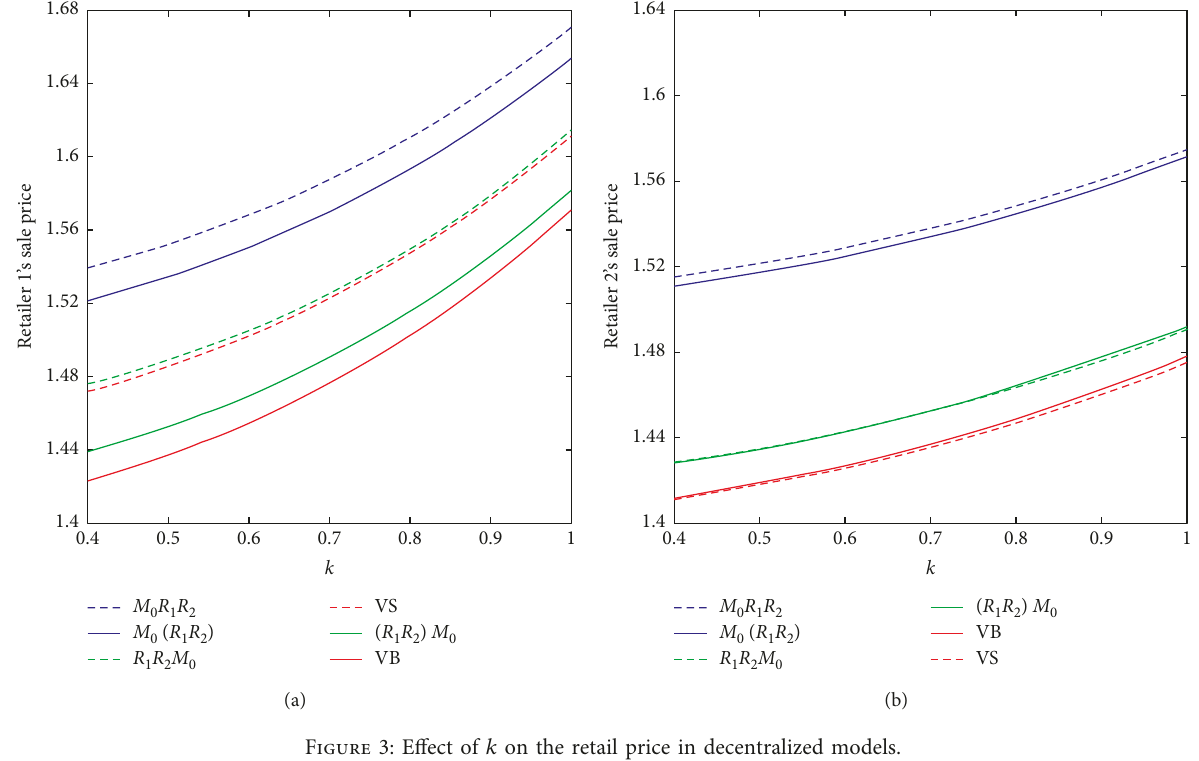
Figure 3: Effect of k on the retail price in decentralized models.